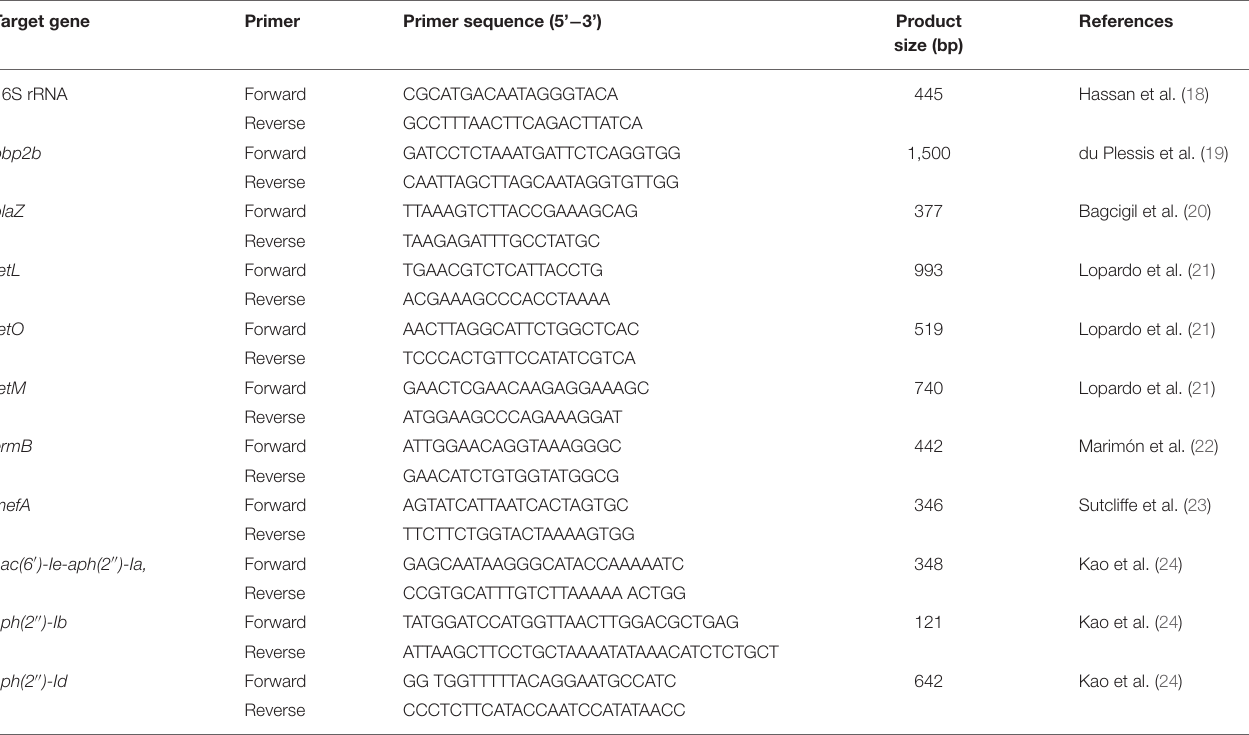
TABLE 1 | DNA Sequences, target genes, and expected product sizes of PCR primers used for the identification of Streptococcus uberis and detection of antimicrobial resistance genes. Target